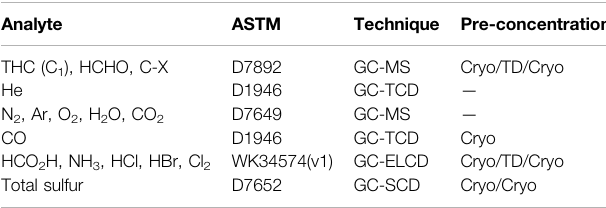
TABLE 3 | Analytical methods used by Smart